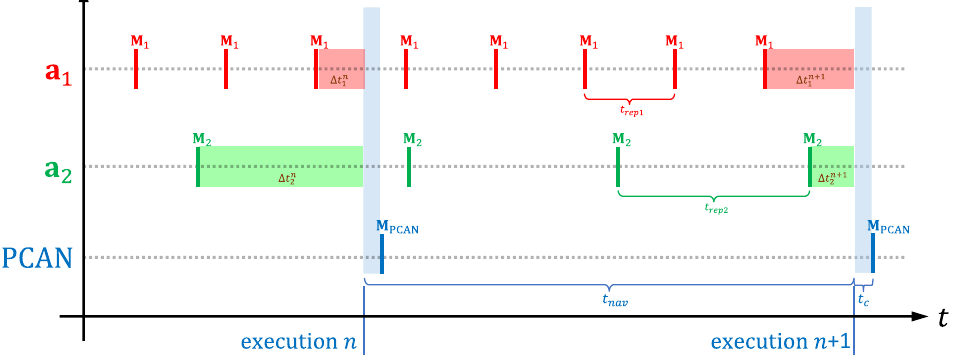
Figure 4. PCAN time behavior.